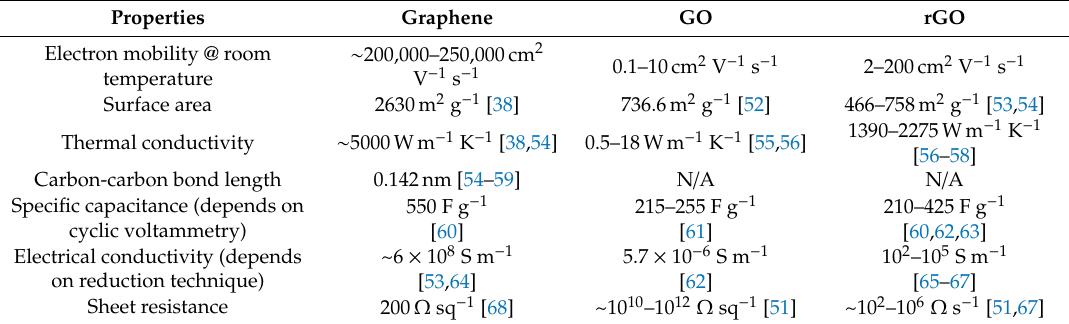
Table 1. Graphene, graphene oxide (GO), and reduced graphene oxide (rGO) properties in general.